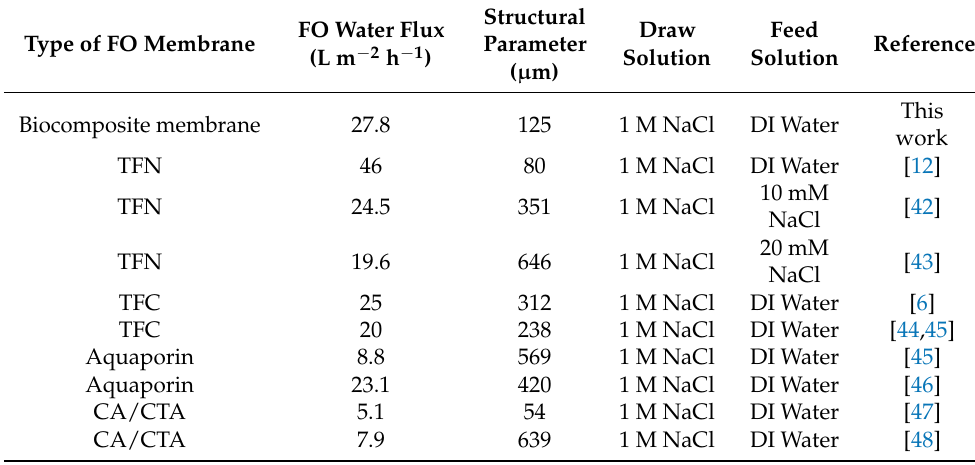
Table 2. Comparison of FO performance with various types of membranes.